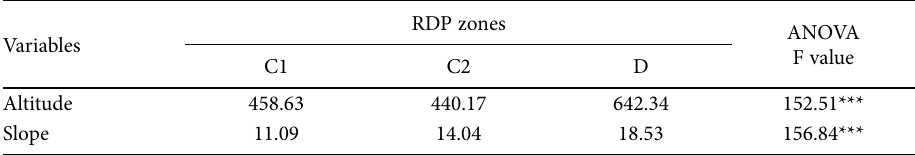
Table 9. Mugello - Average altitude (m a.m.s.l.) and slope (%) of Mugello RDP zones and statistical